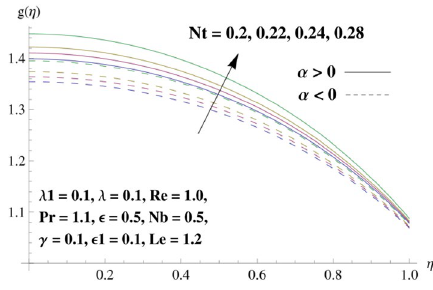
Figure 10. Behavior of g (η) against N t .